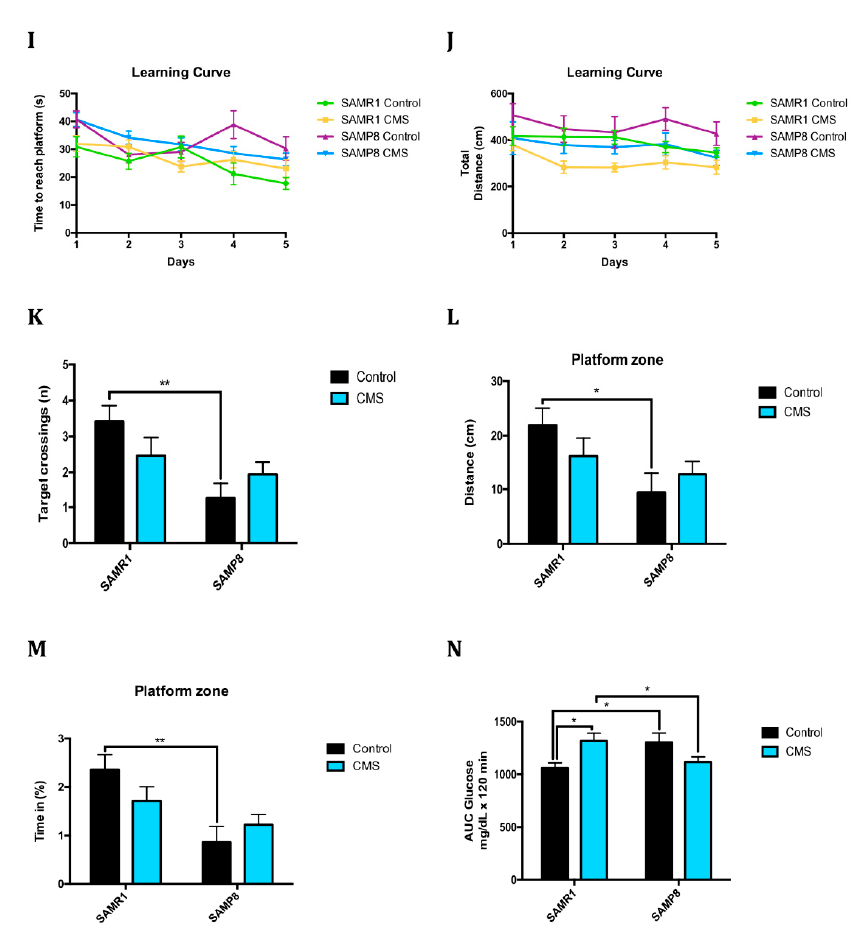
Figure 7. Behavioural and cognitive paremeters after CMS in SAMR1 and SAMP8 mice. Results of OFT for all mice groups. Locomotor Activity ( A ), Ratio of the distance travelled in the Center / Periphery zone ( B ), Time in the Center ( C ) and in the Periphery ( D ), number of Rearing ( E ), and number of Grooming ( F ). Results of NORT for all mice groups. Summary of DI from 2 and 24 h after familiarization phase ( G , H ). Results of MWM for all mice groups. Learning curves of MWM during the spatial acquisition phase ( I , J ), number of Entries ( K ), Distance travelled ( L ), and Time ( M ) in platform zone during the test. Plasma levels of glucose 2 g / kg intraperitoneal (i.p.) administration ( N ). Values are mean ± Standard error of the mean (SEM) ( n = 14 for each group). * p < 0.05; ** p < 0.01; *** p < 0.001; **** p < 0.0001.